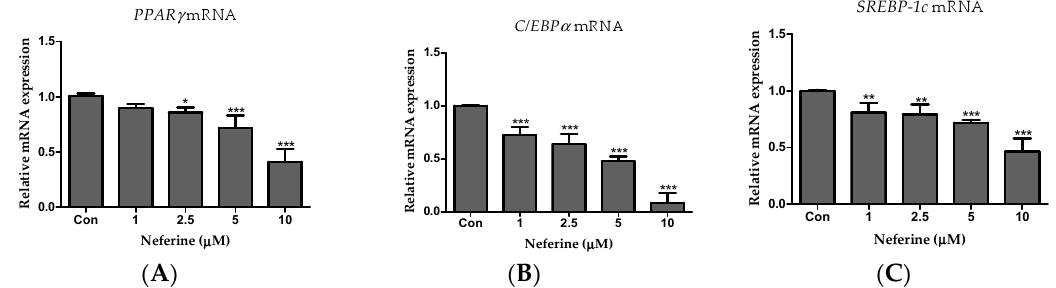
Figure 3. Effects of neferine on the expression of adipogenic marker genes. PCR was used to assess mRNA expression levels of ( A ) PPAR γ , ( B ) C/EBP α , and ( C ) SREBP1c . * p < 0.05, ** p < 0.01, and *** p < 0.001 vs. Con. All data are presented as mean ± SD, and experiments were performed at least thrice. The positive control (Con) was differentiated 3T3-L1 cells treated with adipocyte differentiation cocktail.